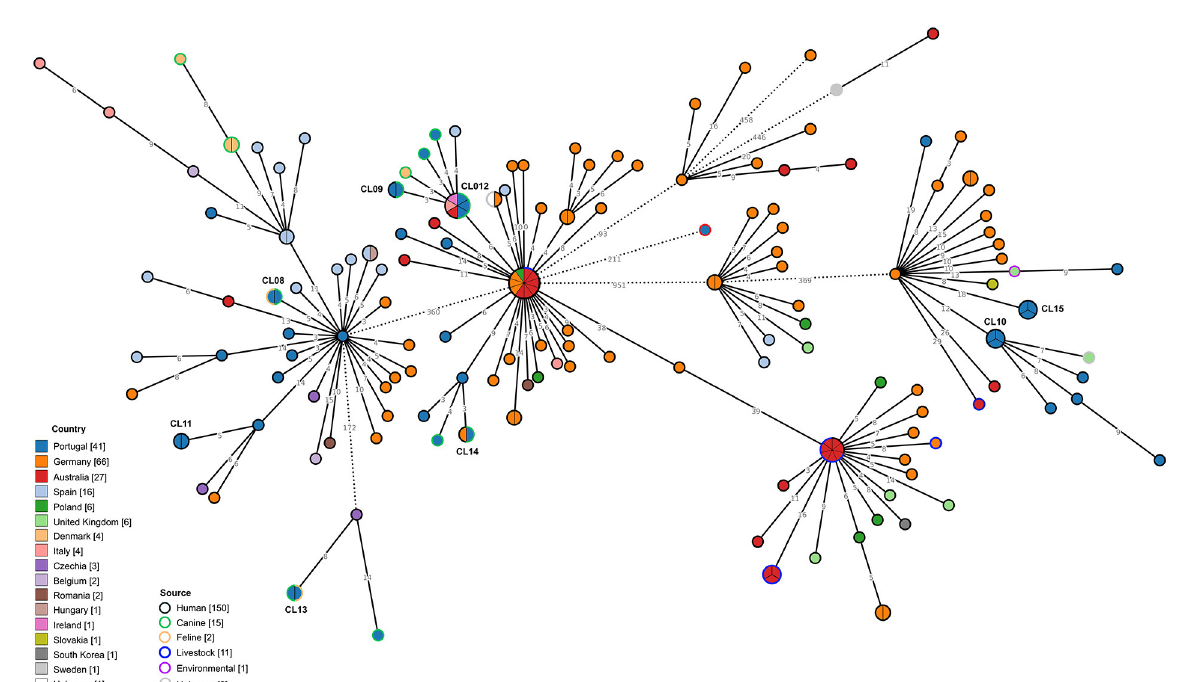
FIGURE4 Phylogeny of Clostridioides difficile isolates from ribotypes 014/020 used in the present study. The minimum spanning tree (MST) was constructed based on the core-SNP diversity found among 183 isolates, relative to reference genome S-0352 (CP076377.1). All nodes (which represent a unique allelic profile) presenting an SNP distance ≤ 2, representing clusters with potential epidemiological relevance, have been collapsed for visualization purposes. Straight and dotted lines reflect nodes linked with the SNP distances below and above 100 respectively. Nodes are colored according to different countries of origin and their contour colored by respective source. The MST was generated using GrapeTree v1.5.0 software